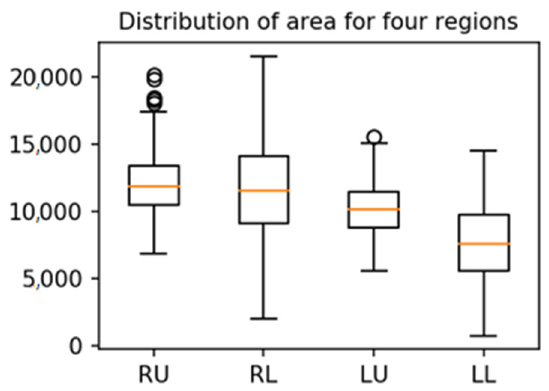
Figure 6. Boxplots of mean intensities for four-regions. The mean intensity of LLR, where the heart is not included in the segmentation algorithm, is lower than the intensities of other regions.